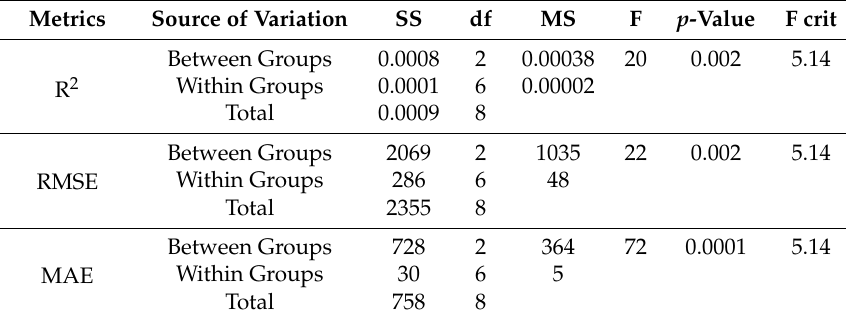
Table A2. Summary of ANOVA analysis test between the investigated algorithms performance in simulating TRMM precipitation for the year 2018.